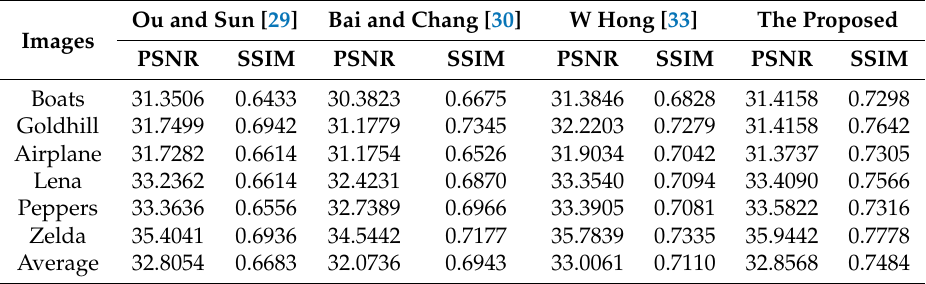
Table 2. Performance comparison of the PSNR and SSIM among the proposed and previous schemes (using 120,000 bits).